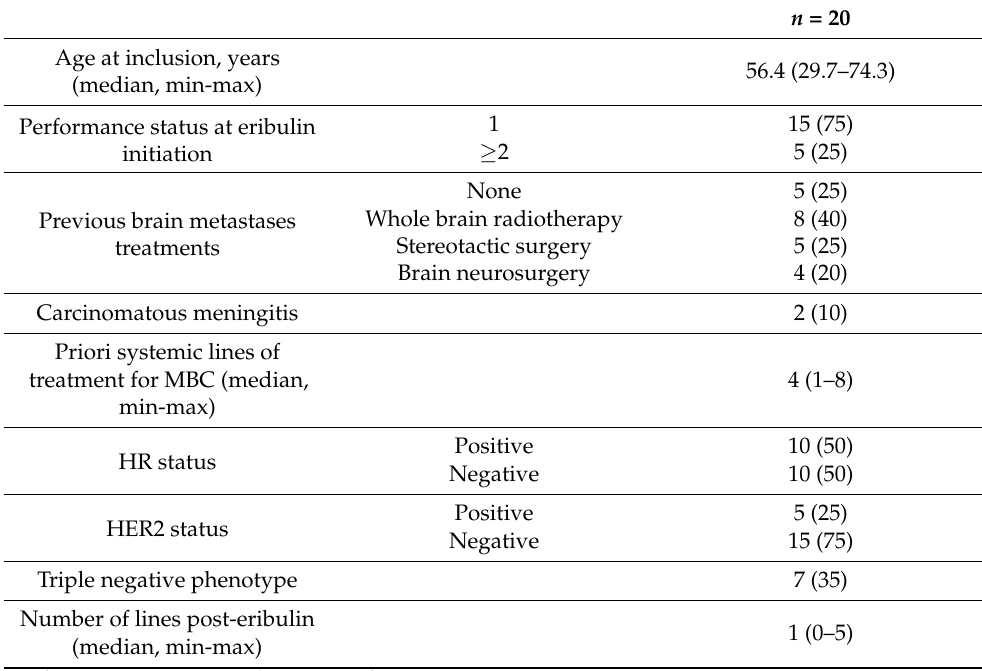
Table 1. Clinical and pathological features at inclusion. When required, results are notified as n (% of cases with data